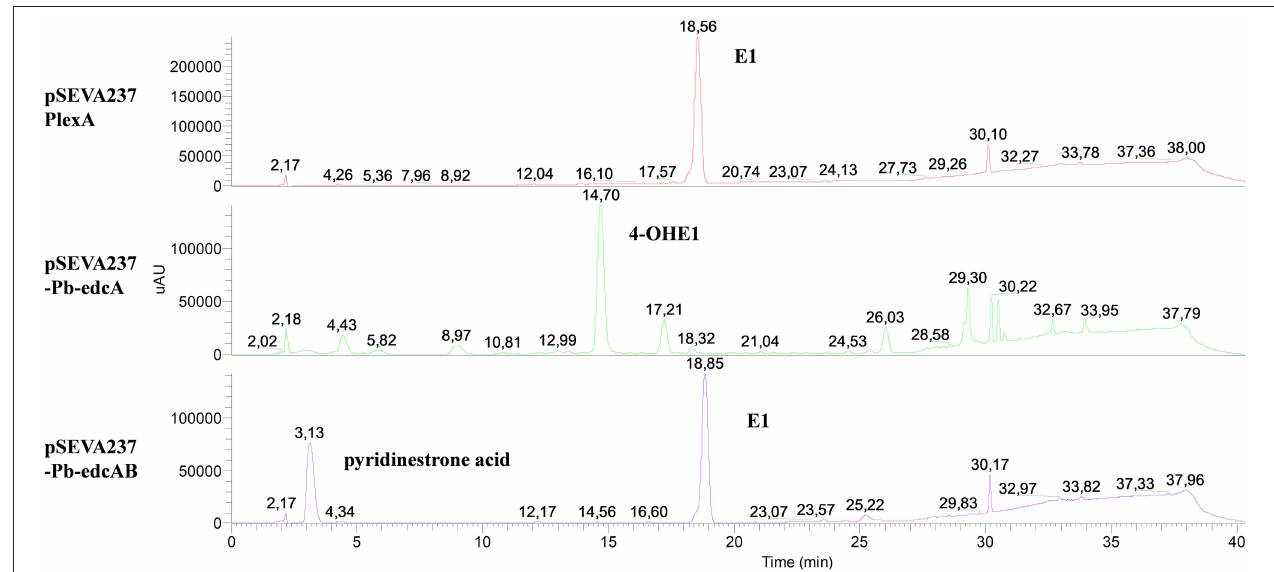
FIGURE 11 | HPLC-MS analysis of the organic fraction extracted from cultures of N. tardaugens 1 Prom (pSEVA23-PlexA), 1 Prom (pSEVA237-Pb-edcA), and 1 Prom (pSEVA237-Pb-edcAB) growing on NB rich medium supplemented with 2mM E1 from samples at 38h. DAD ( diode array detector ) chromatograms at